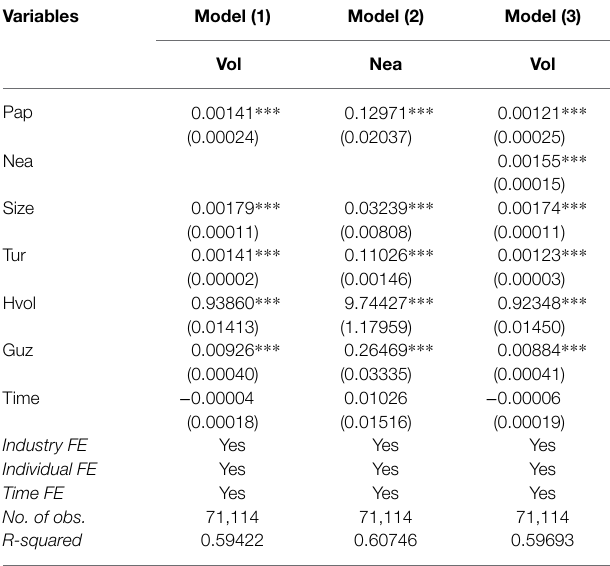
TABLE 5 | The mediating effect of investor